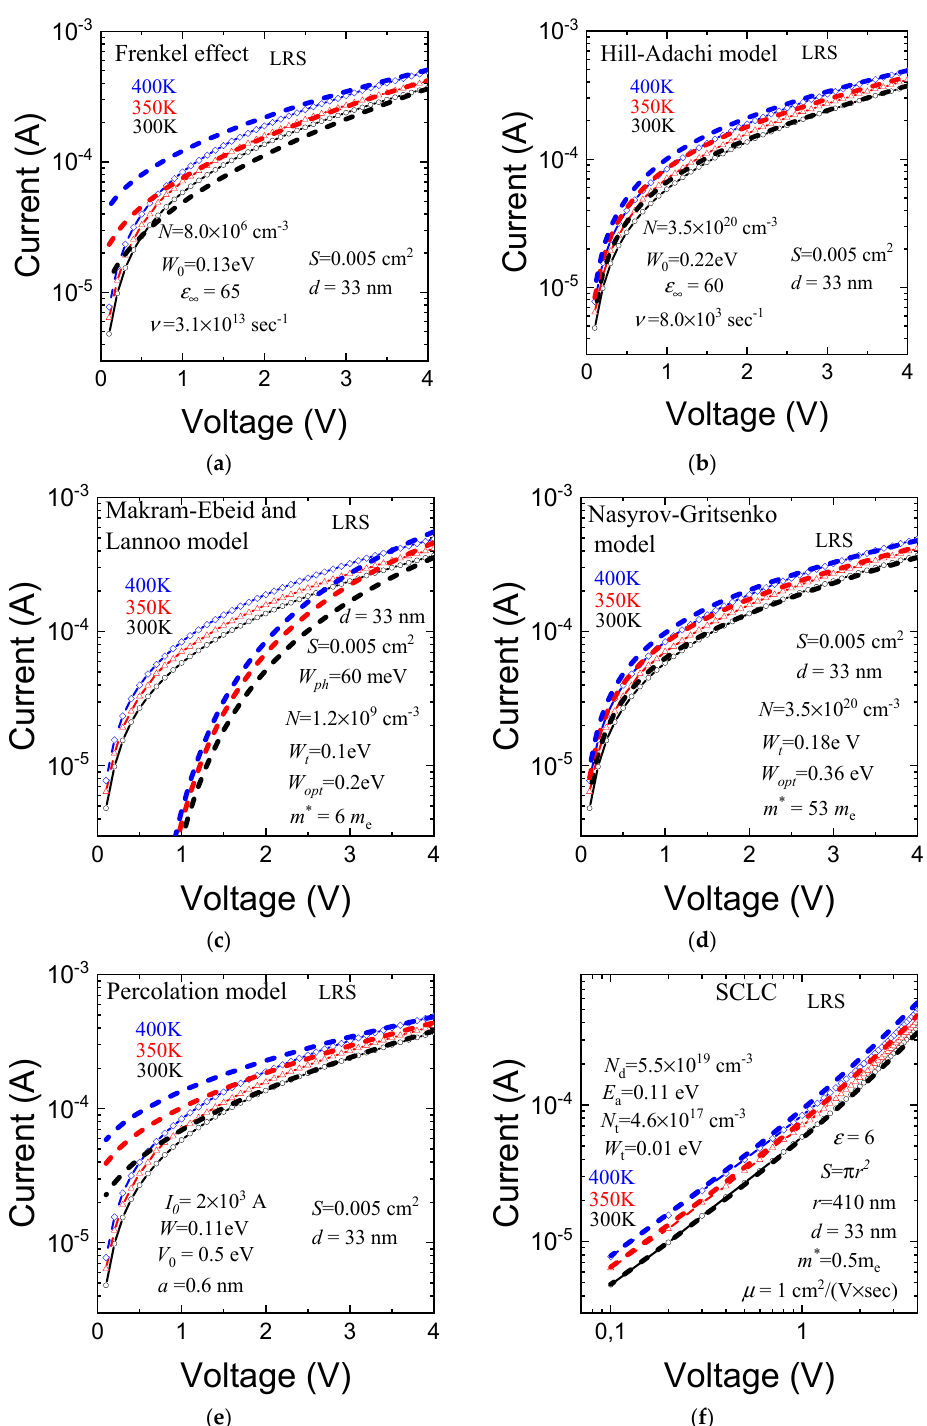
Figure 5. IV characteristics of the PECVD SiO 0.9 N 0.6 -based memristor and the results of simulation by the bulk-limited models in the HRS: ( a ) Frenkel effect; ( b ) Hill–Adachi model of overlapping Coulomb potentials; ( c ) Makram–Ebeid and Lannoo model of multiphonon isolated trap ionization; ( d ) Nasyrov–Gritsenko model of phonon-assisted tunneling between traps; ( e ) Shklovskii–Efros percolation model; and ( f ) SCLC model.